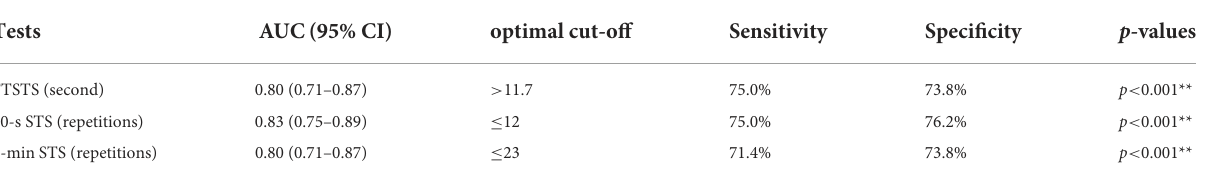
TABLE 6 ROC analysis of discriminatory capability of STS tests on 6MWD over